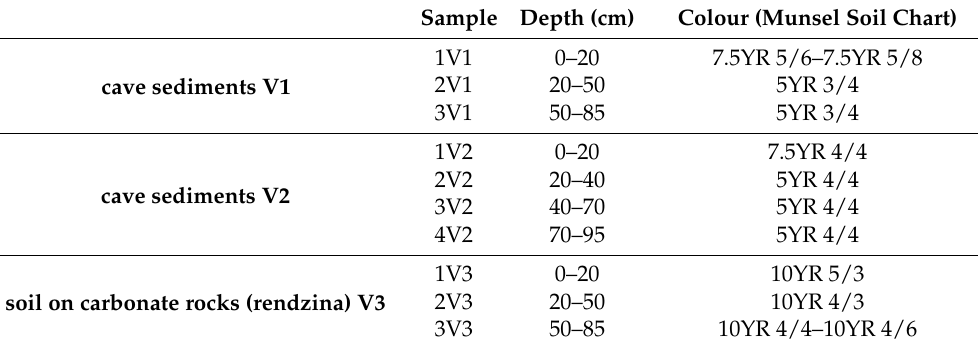
Table 2. The soil colour of the